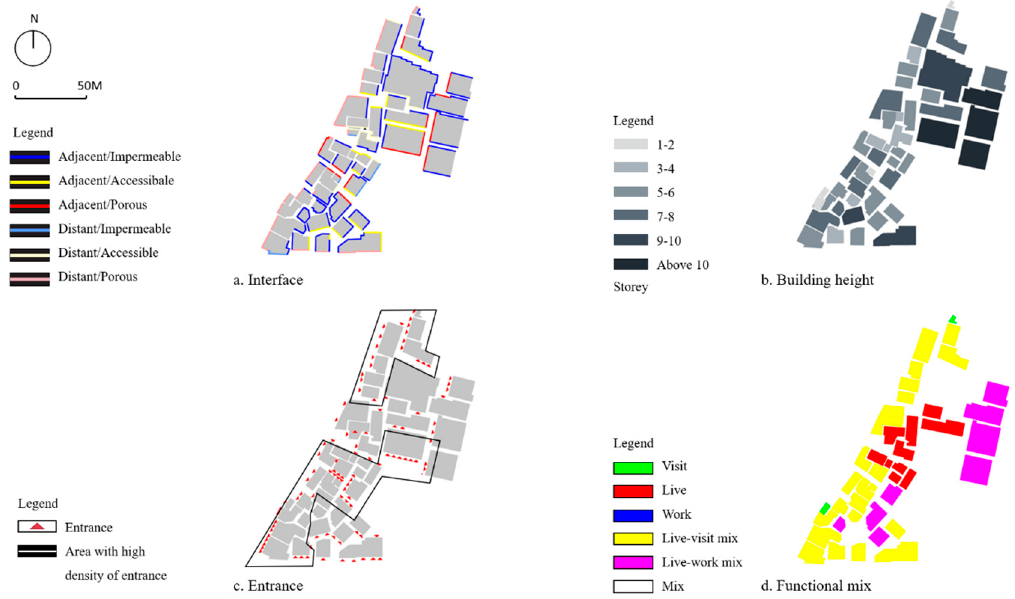
Figure 18. Maps of ( a ) urban interfaces, ( b ) building height, ( c ) entrance, and ( d ) functional mix.